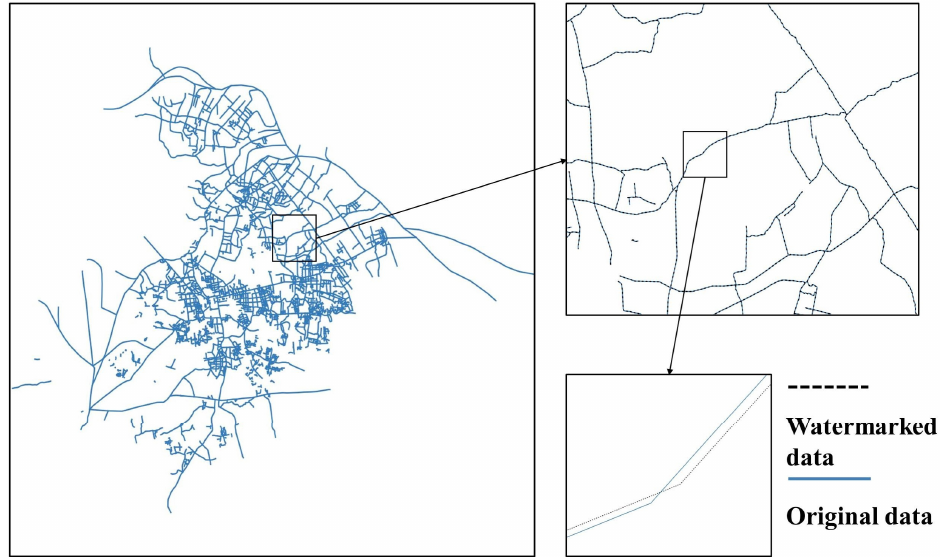
Figure 8. Overlay of original data and watermarked data. We choose rivers for instance. Table 2. Error analysis for the experiment data with different embedding strength.